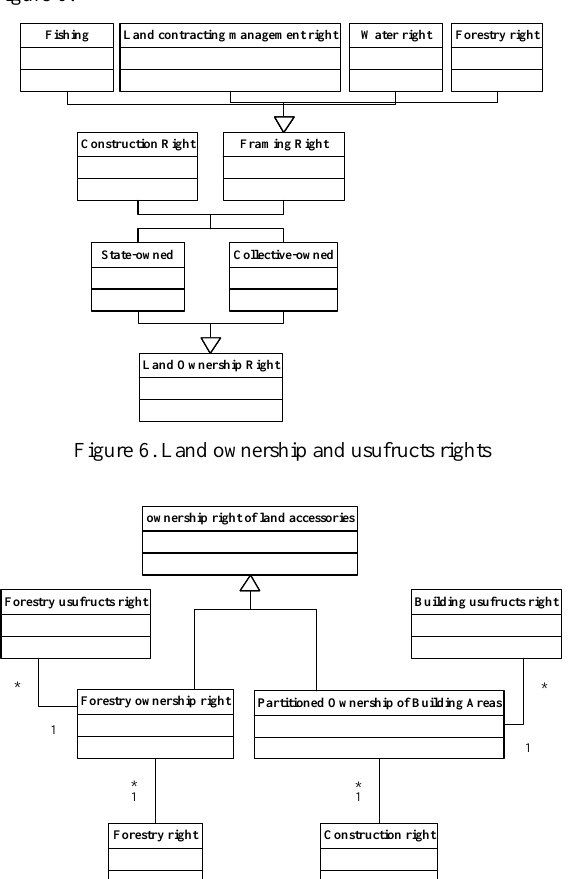
Construction rightForestry